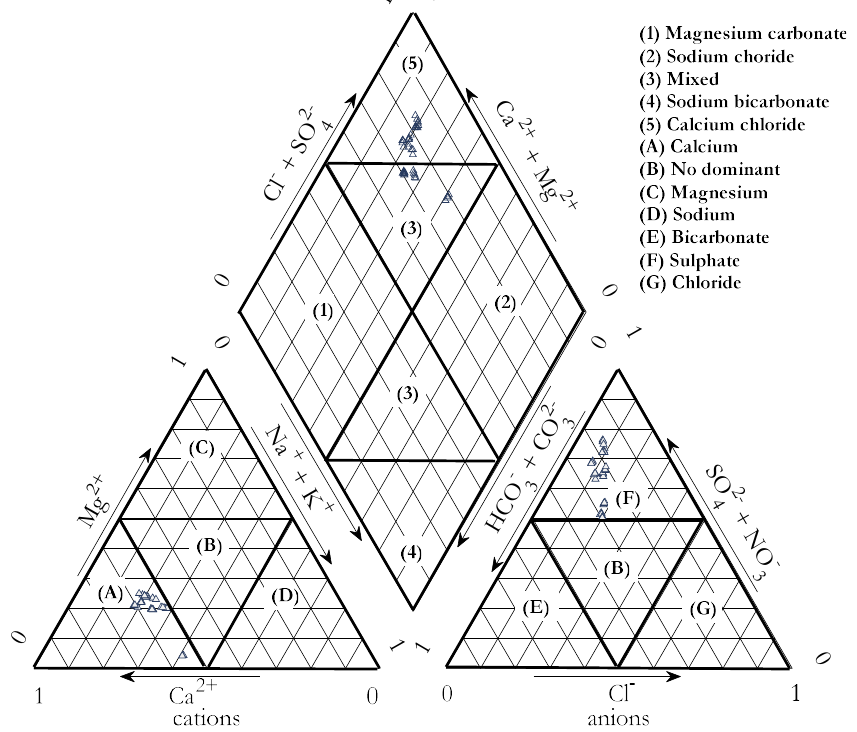
Figure 2. Piper diagram to characterize water chemistry of the Kanawha River using 45 water samples collected during 2016–2018 (further information in Table